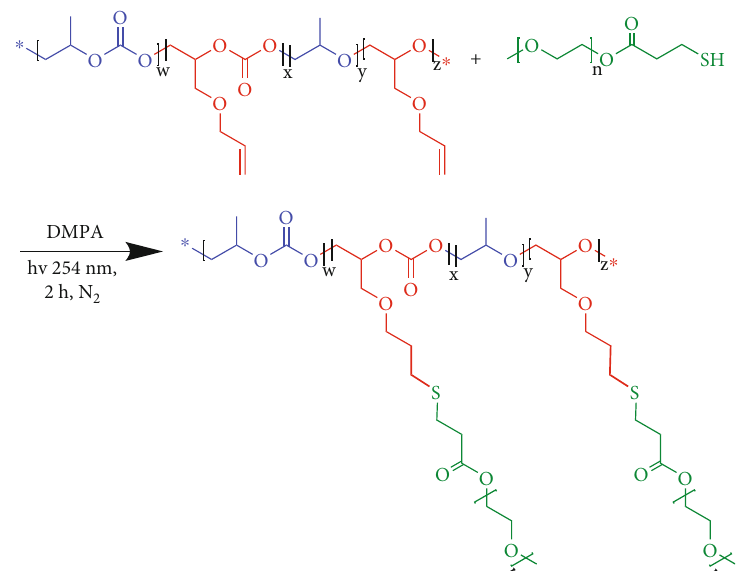
Scheme 3: Synthesis of PPCAGE-g-mPEG grafted polymer.